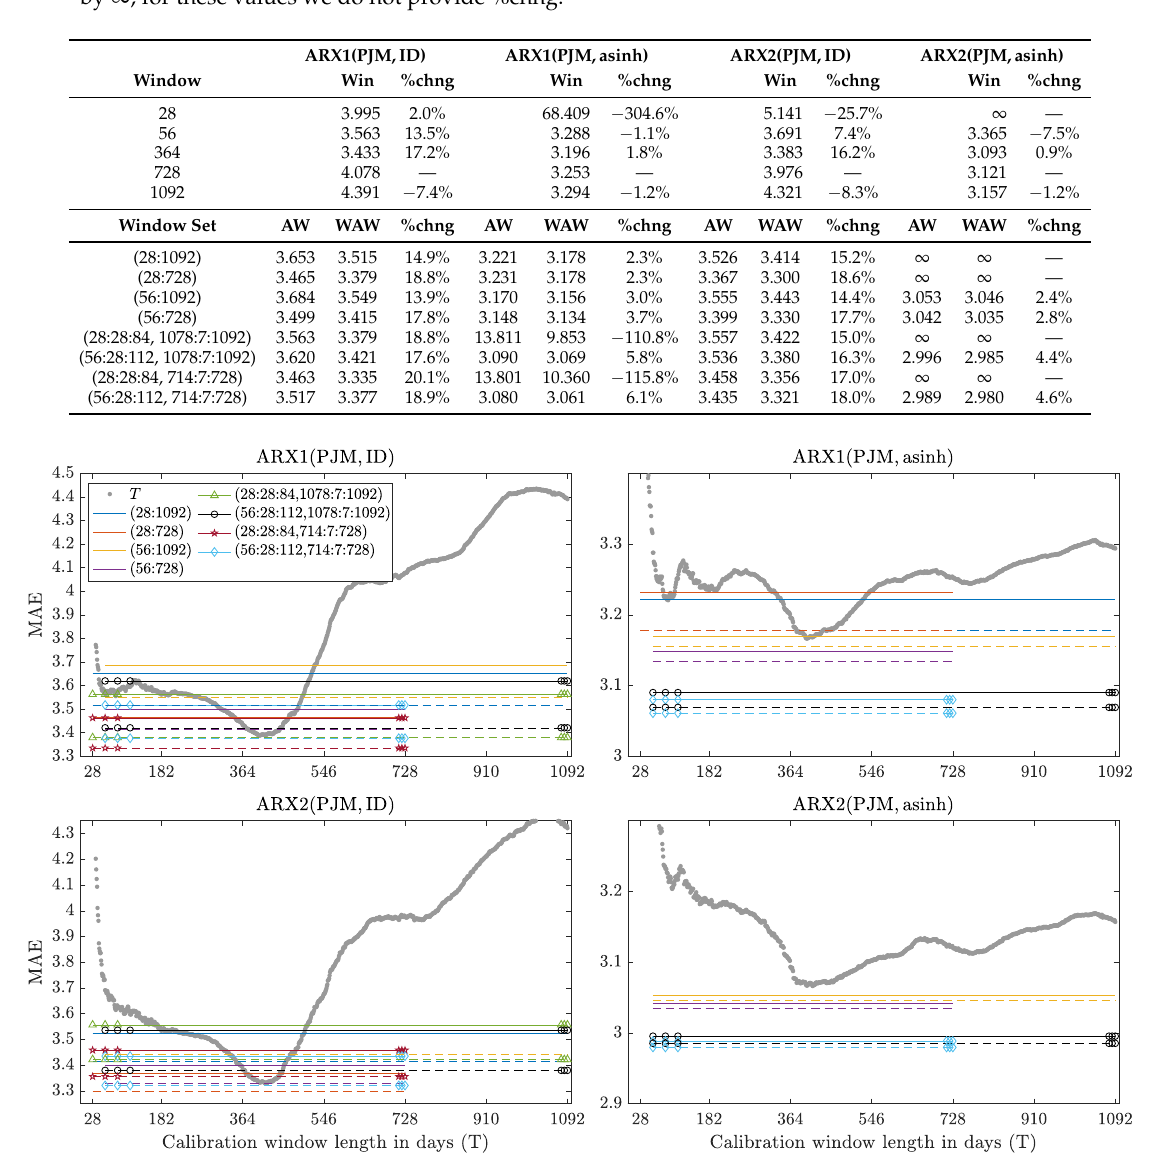
Figure 5. Mean absolute errors (MAE) for the PJM dataset as a function of the window length T = 28,...,1092 (gray circles) and obtained by combining forecasts (the color/line/symbol scheme and the location of panels is the same as in Figure 4). Note the different scales. Out-of-range lines or symbols are not